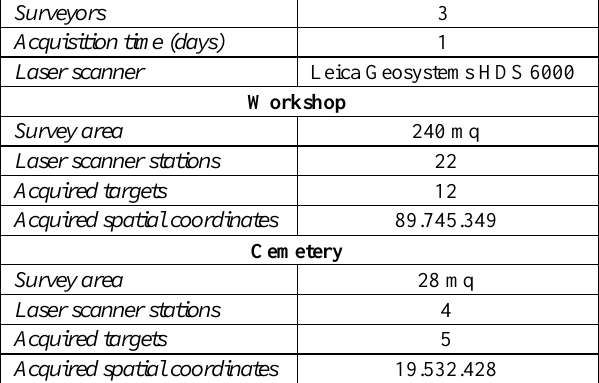
Table 1. Summary of the acquired range